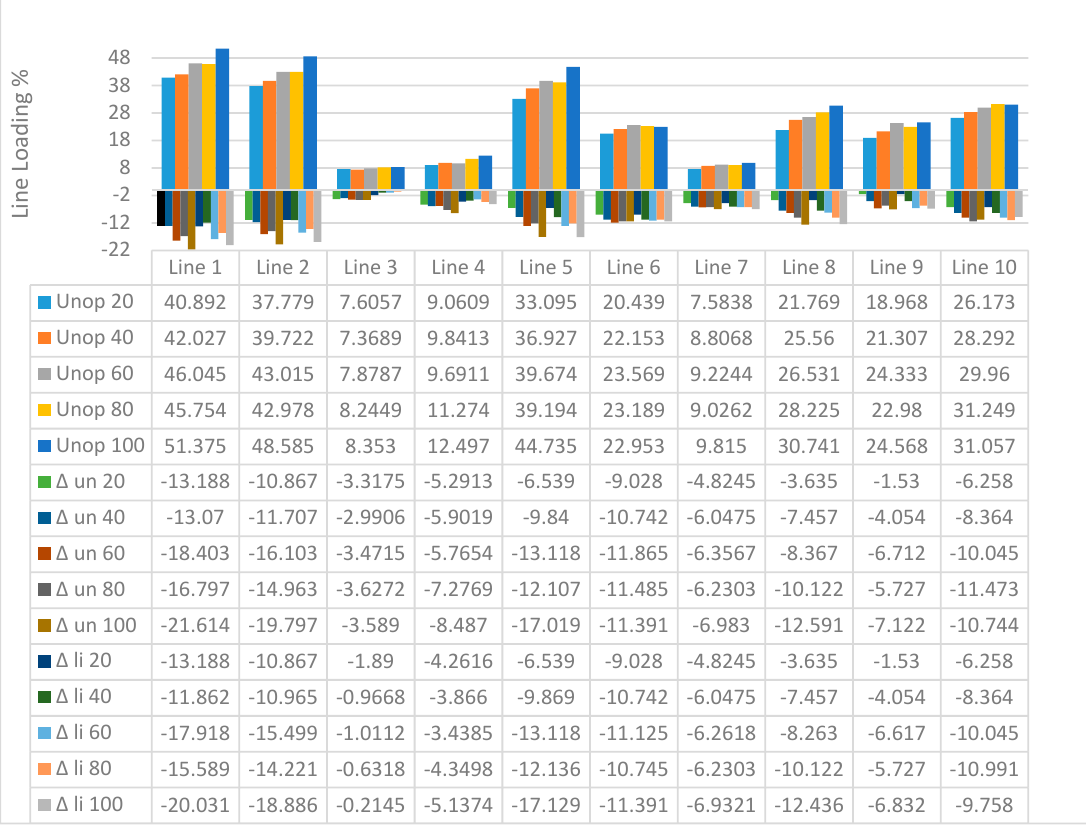
Figure 11. Worst case line loading %–Unop (20–100): unoptimized with 20–100 EVs in the system; ∆ un (20–100) showing the change in loading percentages when optimized with no limit on the configuration for between 20–100 EVs and ∆ li (20–100) showing the results optimized for minimizing peak line loading across all lines with no limit on configuration for between 20–100 EVs.